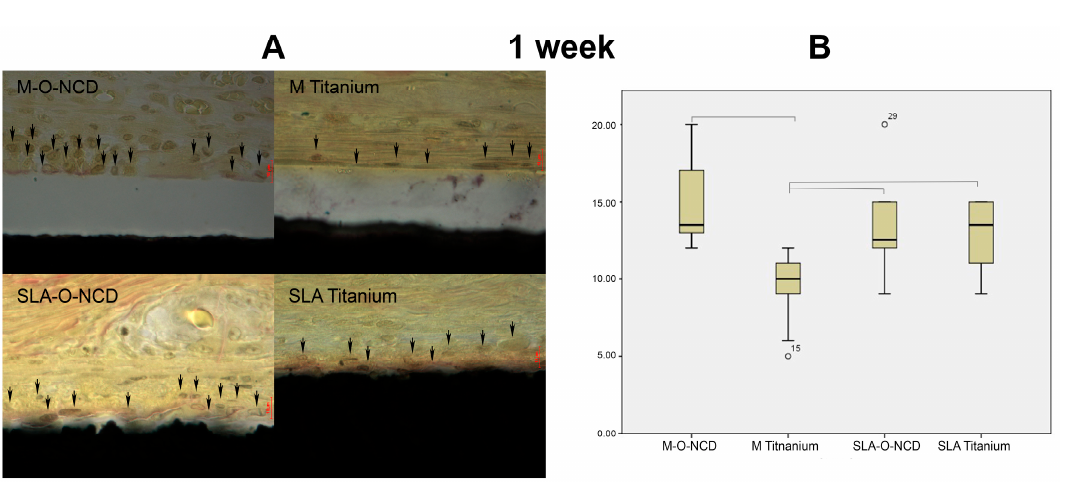
Figure 2 . Van Giesson staining ( A ). After 1 week, more cells (black arrows) were seen in proximity to the machined hydrophilic surface compared with the other surfaces. The red scale bar indicates a 10 µm distance. Graph ( B ) shows the number of cells within a 10 µm distance to the surface after 1 week. Machined hydrophilic surfaces attracted the most cells, but significant differences were also observed between M Titanium and the other groups.